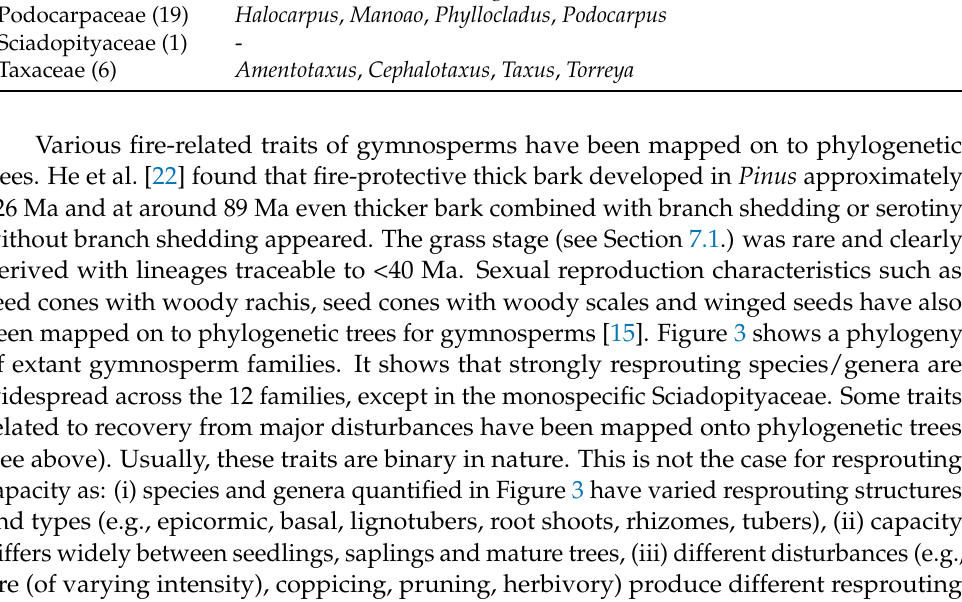
Figure 3. Phylogeny of extant conifer families (adapted from Figure 5 of Lu et al. [23] ). Numbers in brackets represent number of resprouting genera/number of genera in the family; number of species resprouting after 100% leaf scorch/total number of species in the family.